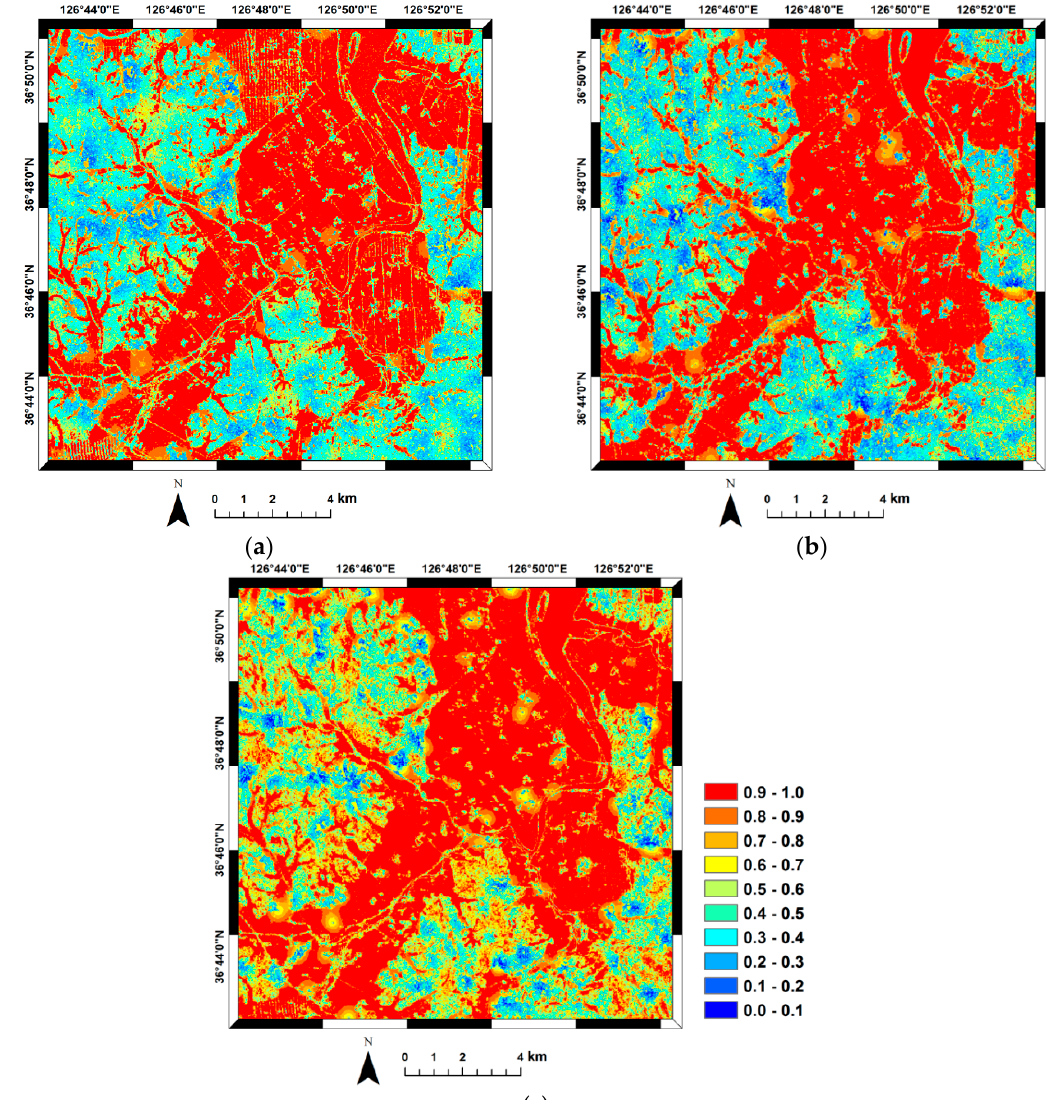
Figure 7. Classification accuracy probability maps: ( a ) Radarsat-1; ( b ) ENVISAT ASAR; and ( c ) fusion.